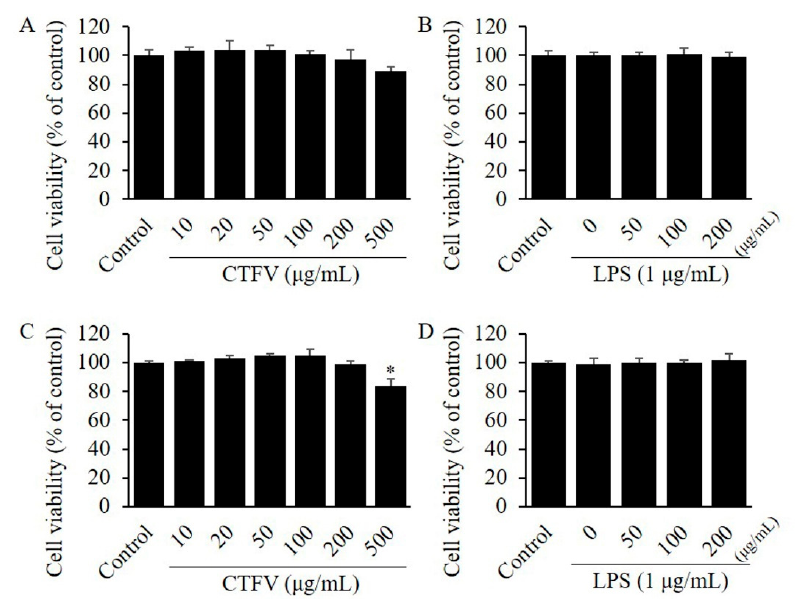
Figure 2. Assessment of cytotoxic effects. MTT assay showing the effect of CTFV on RAW264.7 ( A , B ), and 3T3-L1 cells ( C , D ) viability. Cells were incubated with the compound at different concentrations (0–500 µg/mL) or LPS at 1 µg/mL for 24 h and cell viability was analyzed by MTT reduction assay. MTT, 3-(4,5-dimethylthiazol-2-yl)-2,5-diphenyltetrazolium bromide; CTFV, C. tricuspidata fruits vinegar;